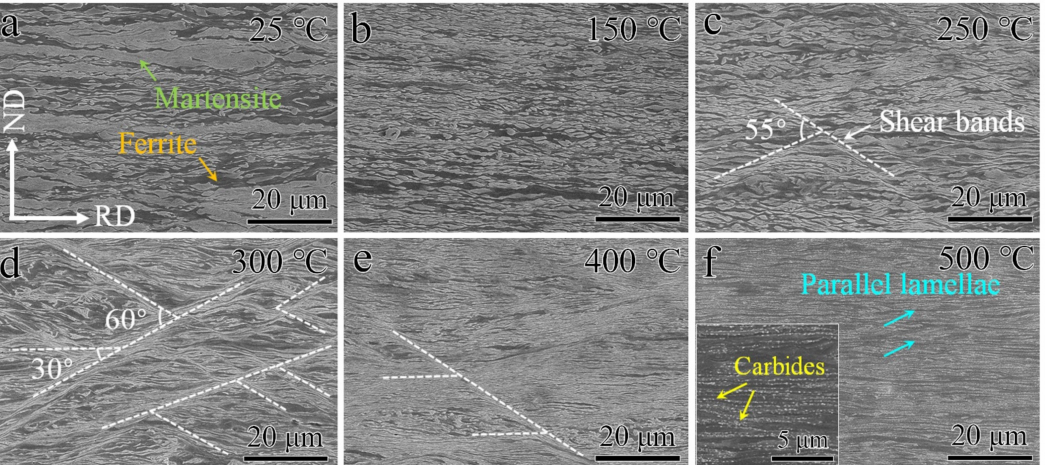
Figure 2. SEM morphologies of the dual-phase heterostructured steel rolled at different temperatures with 85% thickness reduction: ( a ) 25 ◦ C, ( b ) 150 ◦ C, ( c ) 250 ◦ C, ( d ) 300 ◦ C, ( e ) 400 ◦ C, ( f ) 500 ◦